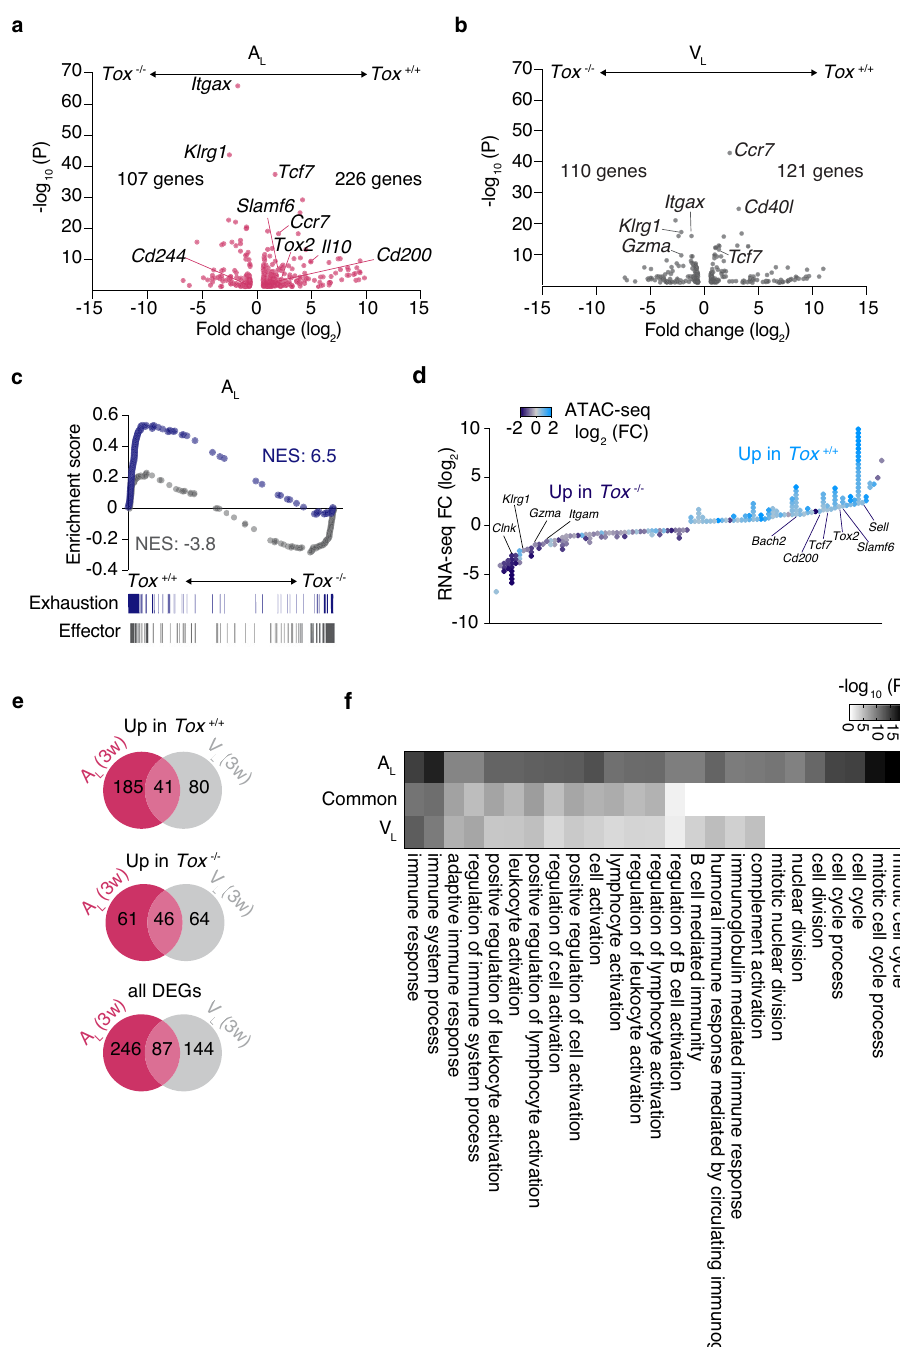
Fig. 5 TOX imposes a gene program of exhaustion in self-reactive CD8 + T cells. 10 4 naive Tox + / + or Tox − / − P14 cells were adoptively transferred into MOG-GP ( a , c – f ) and WT mice ( b , e , f ). One day later (day 0), mice were challenged i.c. with 10 4 PFU rLCMV-GP33. Brain in fi ltrating P14 cells were FACS sorted for RNA-seq ( a – f ) and ATAC-seq ( d ) 21 days later. a Volcano plot of differentially expressed genes (DEGs) (FC ≥ 1.5; FDR ≤ 0.05) in Tox + / + vs. Tox − / − A L cells ( n = 3 mice/group). b Volcano plot of differentially expressed genes (DEGs) (FC ≥ 1.5; FDR ≤ 0.05) in Tox + / + vs. Tox − / − V L cells ( n = 3 mice/group). c GSEA of a signature of exhaustion and effector differentiation 33 in a ranked list of genes differentially expressed by Tox + / + vs. Tox − / − A L cells. NES: normalized enrichment score. d Diamond plot of differentially accessible ChARs adjacent to the top 50 up- and downregulated genes identi fi ed in ( a ). Top DEGs which possess at least one differential ChAR within a 15 kb distance are shown. Each diamond represents a ChAR assigned to a gene. Color code depicts the gain or loss of accessibility (Log 2 FC) in the comparison Tox + / + vs. Tox − / − A L cells. e Venn diagram showing the overlap of DEGs found in the comparisons Tox + / + vs. Tox − / − in both A L and V L cells. f Enrichment of biological processes (GO terms) among the DEGs (up in Tox + / + vs. Tox − / − ) commonly or uniquely found in A L and V L cells. The top 10 most signi fi cantly enriched GO terms are shown for each category.